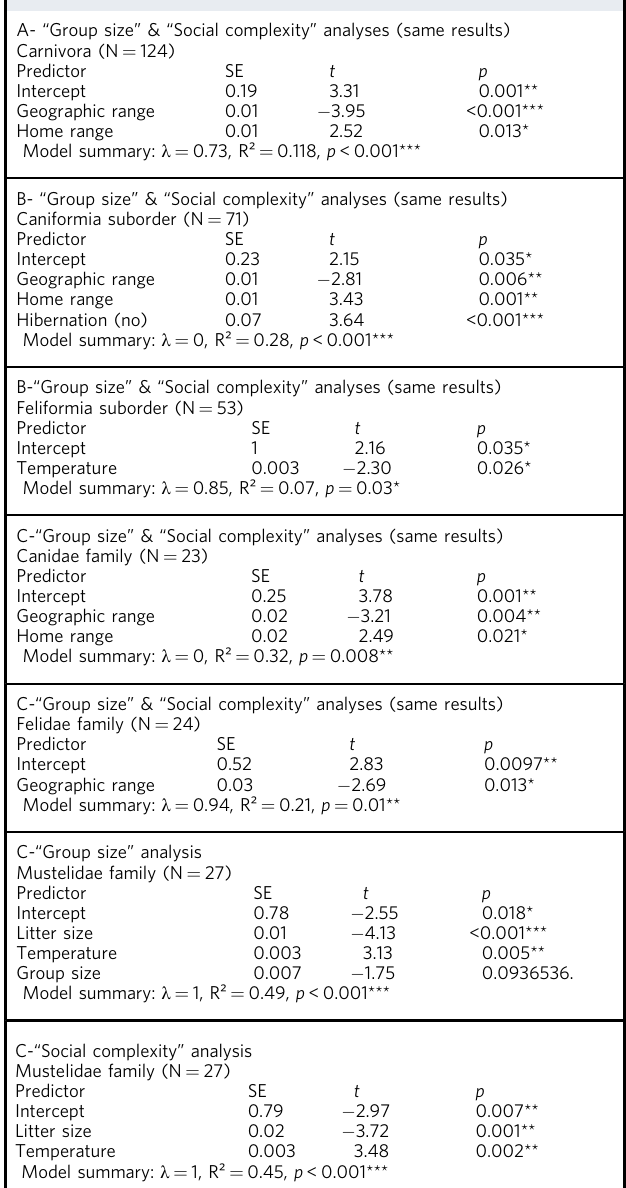
Table 2 PGLS models selected by BIC comparison that best predict the evolution of encephalization for (A) the order Carnivora, (B) the suborders Caniformia and Feliformia, and for (C) the Canidae, Felidae and Mustelidae families.